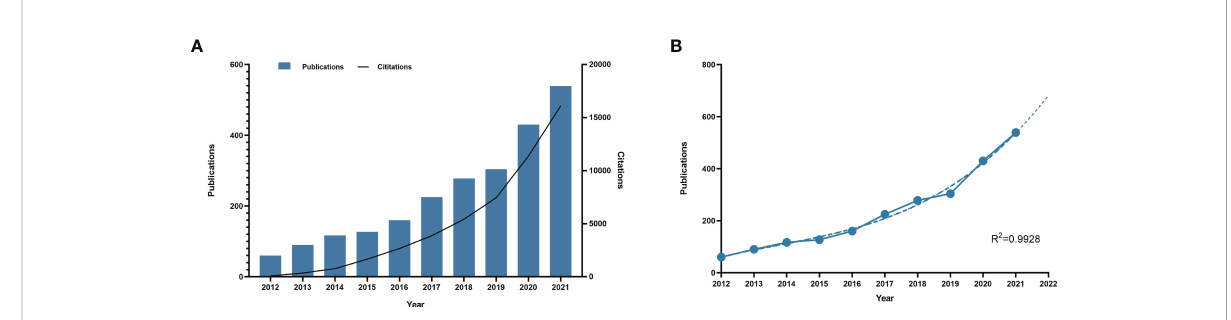
FIGURE 2 Publication outputs and growth forecast. (A) Number of published articles and citations on BC immunotherapy from 2012 to 2021. (B) Model- fi tted curves of prediction of future publication in BC immunotherapy